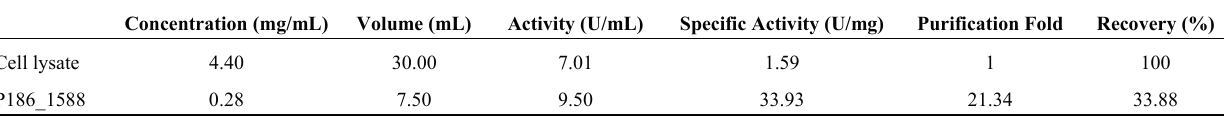
Figure 4. ( A ) SDS-PAGE. Lane 1: protein molecular weight markers; Lane 2: the soluble fraction of the cell lysate after induction; Lane 3: the insoluble fraction of the cell lysate after induction; Lane 4: fluid through Ni-NTA column; Lane 5: purified fraction from Ni-NTA eluted by washing buffer containing 30 mM imidazole; Lane 6: purified